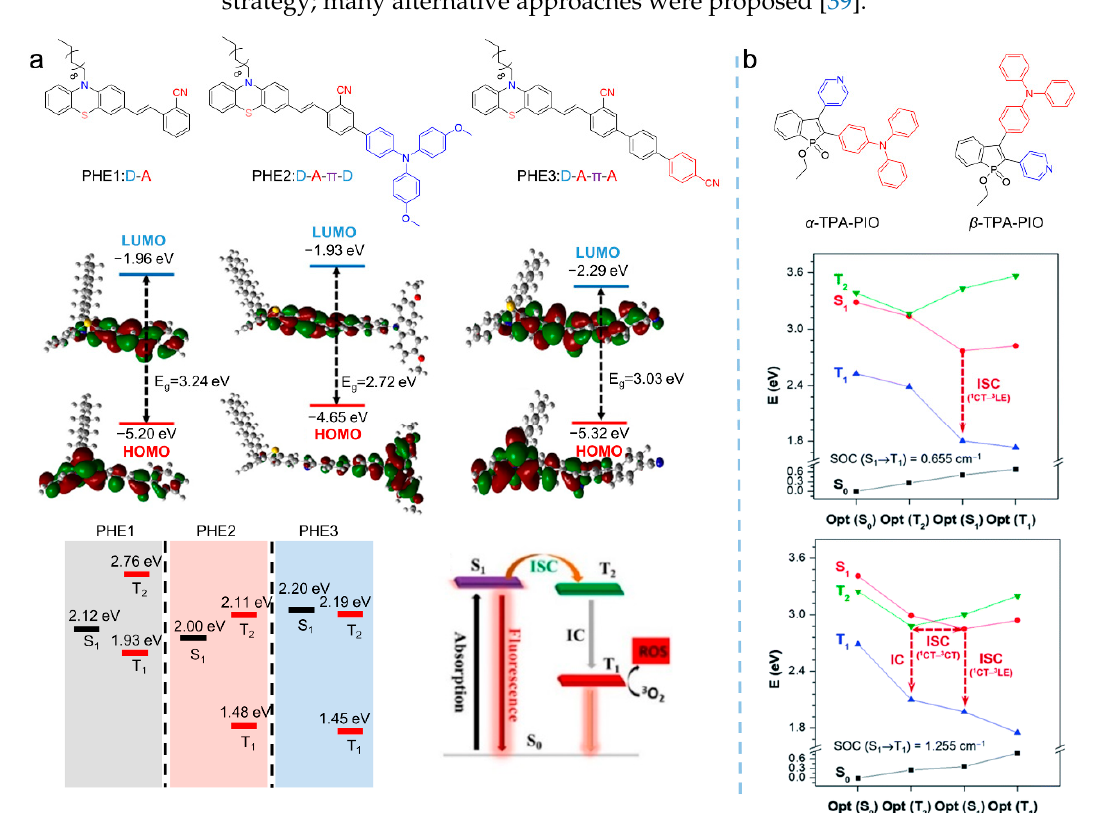
Figure 4. ( a ) Chemical structures, the electron distribution on the frontier orbitals, and the relied mechanism for PHE1-3 to produce type I ROS. Reprinted with the copyright from. [37]. Copyright 2021, Elsevier. ( b ) Chemical structures and calculated energy diagram analysis of α -TPA-PIO and β -TPA-PIO with labels of SOC values. Reprinted with the copyright from [38]. Copyright 2020 by the author(s). Published by the Royal Society of Chemistry.